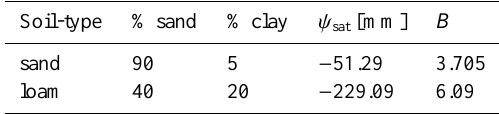
Table 1. Soil type dependent hydrological parameters